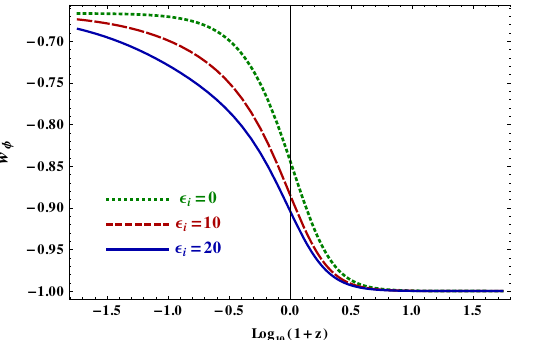
Figure 1. Evolution of scalar field EoS has been shown. Green (dotted), red (dashed) and blue (solid) curves correspond to (cid:101) i = 0, 10, 20 respectively for λ = 1 and Ω m0 = 0.3.